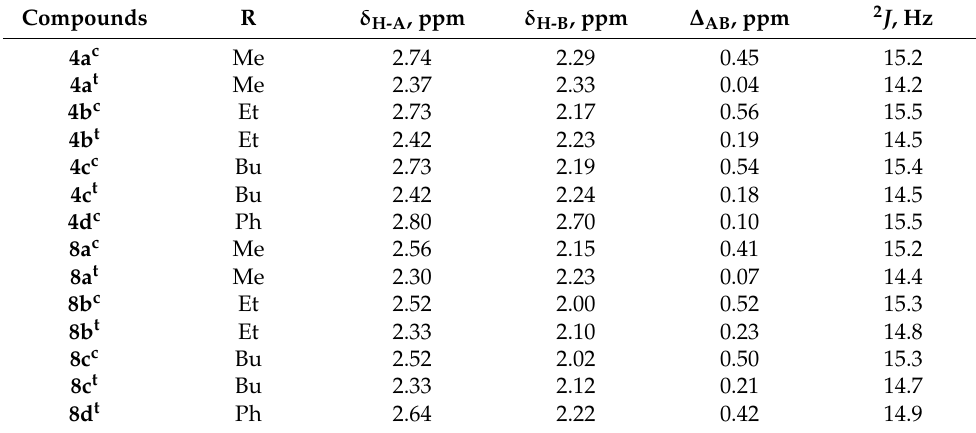
Table 3. Chemical shifts δ H-A , δ H-B and spin-spin coupling constants ( 2 J ) of diastereotopic protons